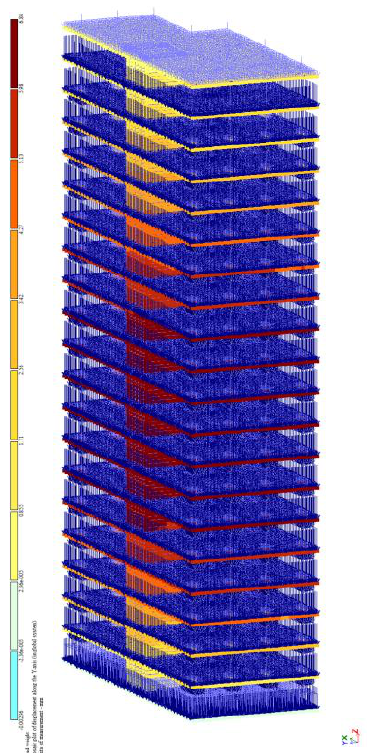
Figure 9 . Displacement field along the X axis in mm.